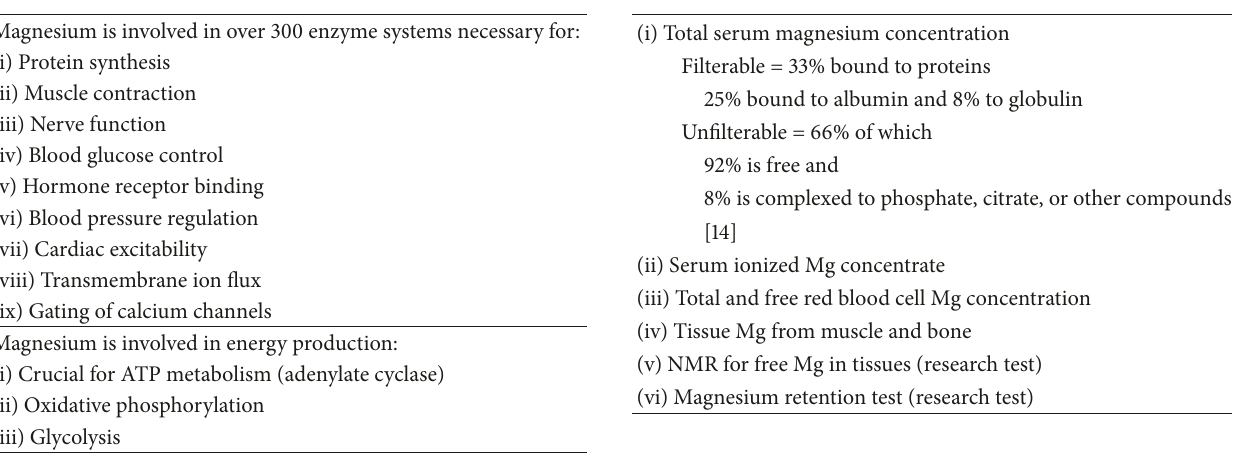
Table 1: Magnesium physiology [13]. Table 2: Measurement of magnesium levels [6,